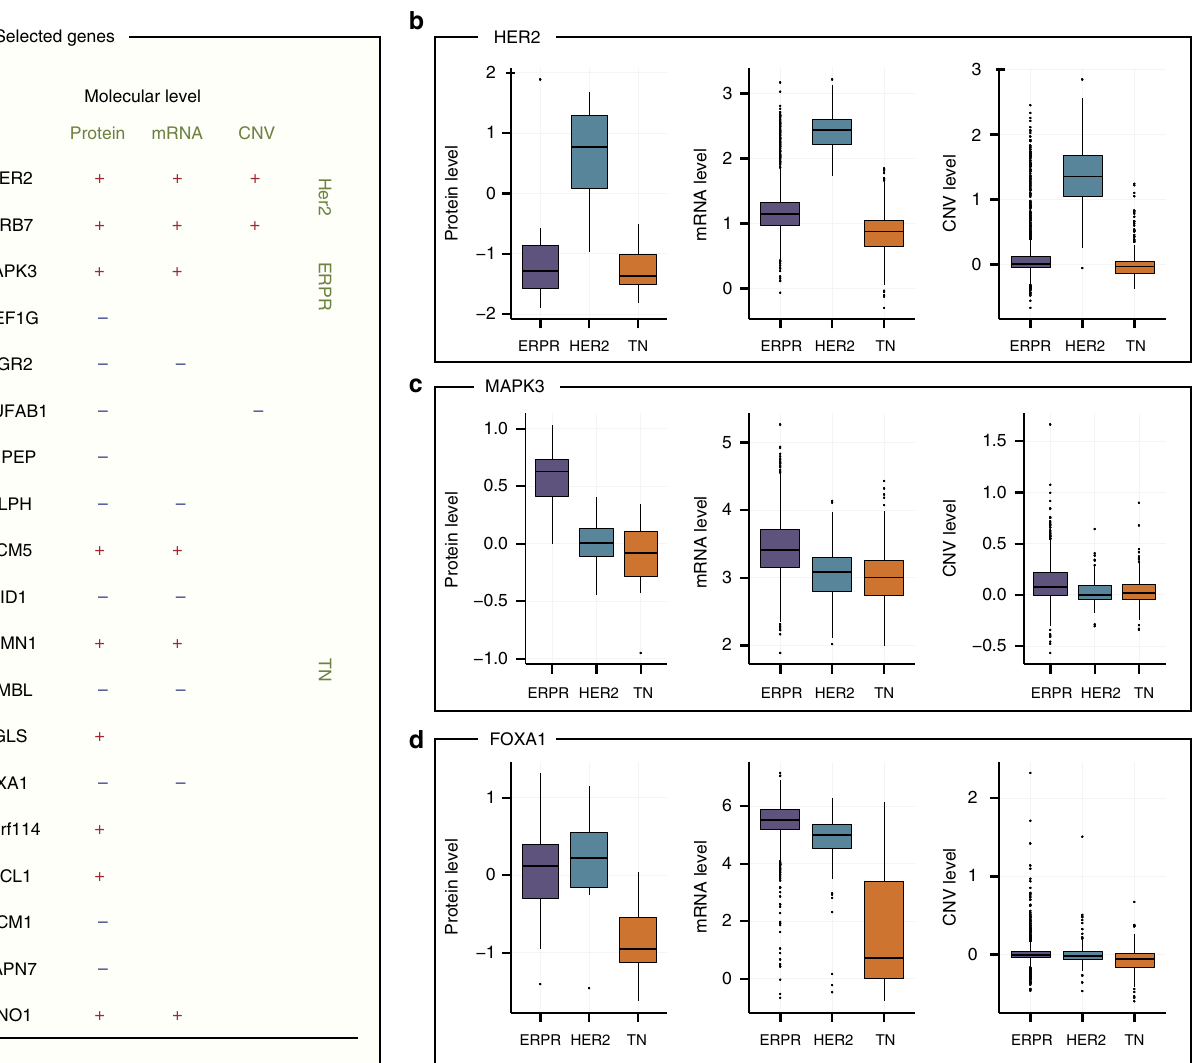
Figure 6 | Comparison of SVM selected proteins on different expression levels. ( a ) Mapping of the 19 signature proteins to RNA and copy number variation (CNV) data from Curtis et al. 5 . Genes with statistically significant difference in expression at a given molecular level are marked by ‘ þ ’ and ‘ (cid:2) ’ if their expression at that level is higher or lower, respectively, in the particular subtype. Comparison of protein expression, mRNA expression and CNV distributions in each subtype are given for three selected proteins: Her2 ( b ), MAPK3 ( c ) and FOXA1 ( d ). All other proteins are presented in Supplementary Fig. 6. Quantitative information and local FDR values ( q values) are given in Supplementary